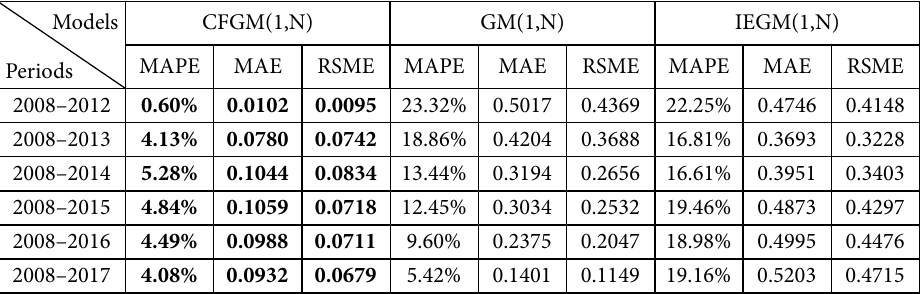
Table 5. Evaluation about the grey model interpretation